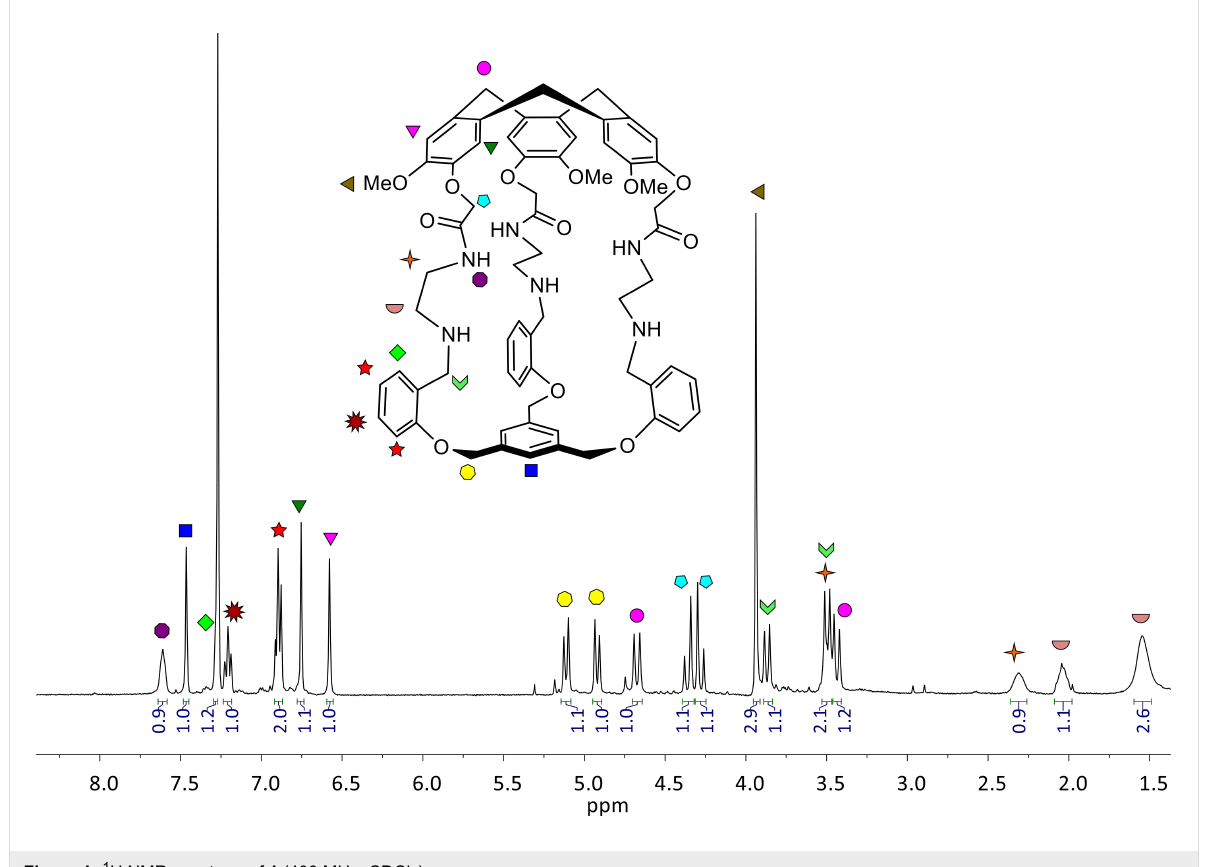
Figure 1: 1 H NMR spectrum of 1 (400 MHz, CDCl 3